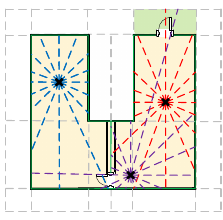
Figure 7. Simulated ray casting from the scanner positions. The yellow cells present a high likelihood of being interior cells, and the green and white cells are likely to be the exterior cells.